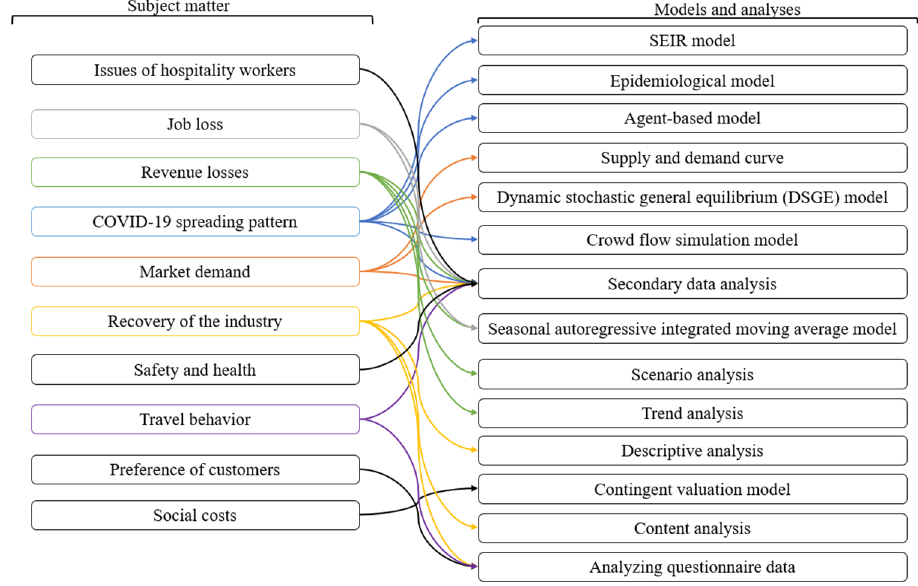
Figure 7. Research models and analyses of included papers.